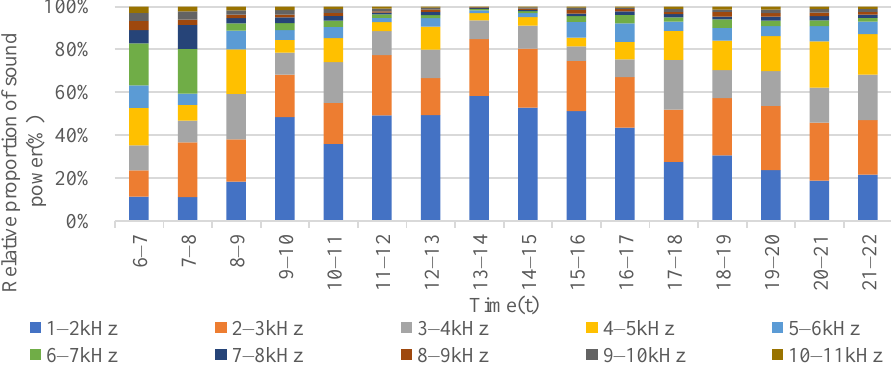
Figure 7. Daily variation of the relative proportion of sound power in each frequency band.